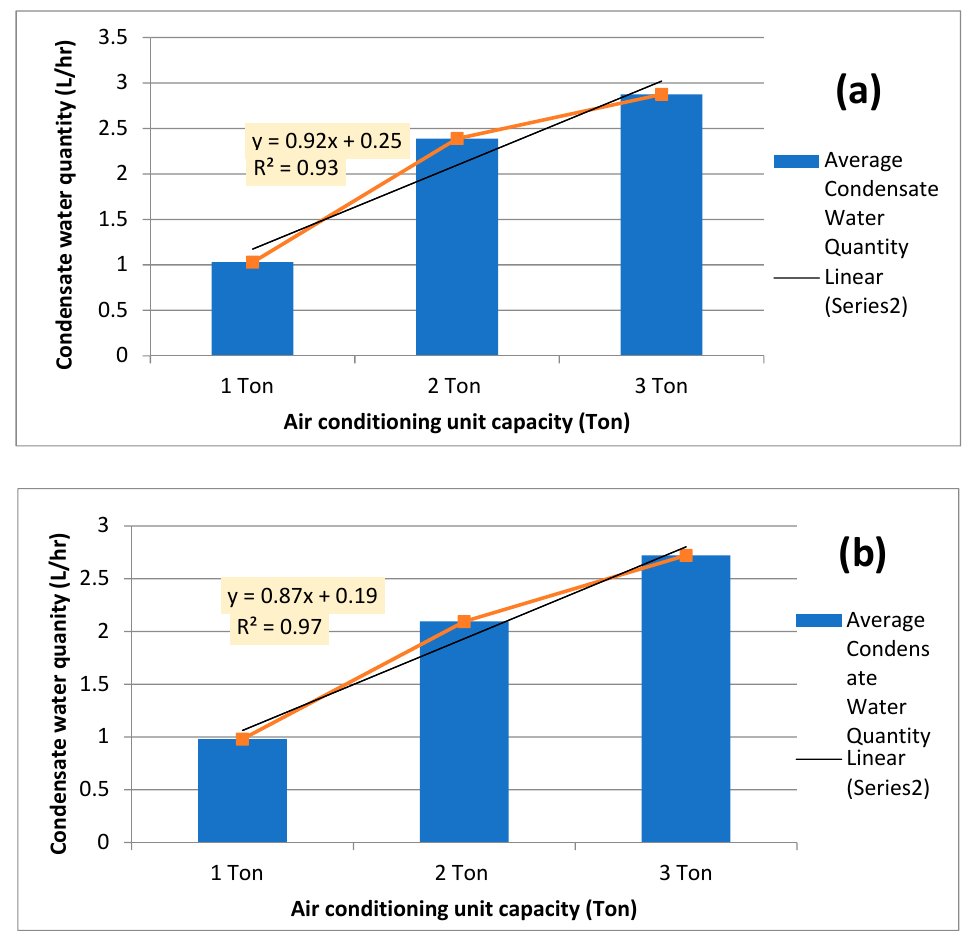
Figure 5. Quantities of condensate water in Jericho city at: ( a ) 18 °C operating temperature and ( b ) 20 °C operating temperature.